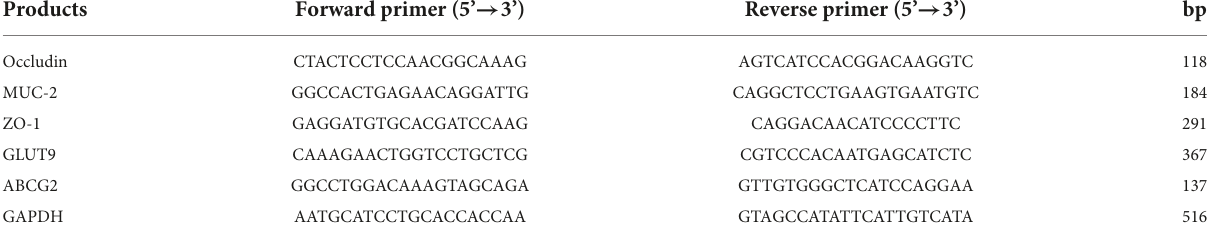
TABLE 1 Primers used in this